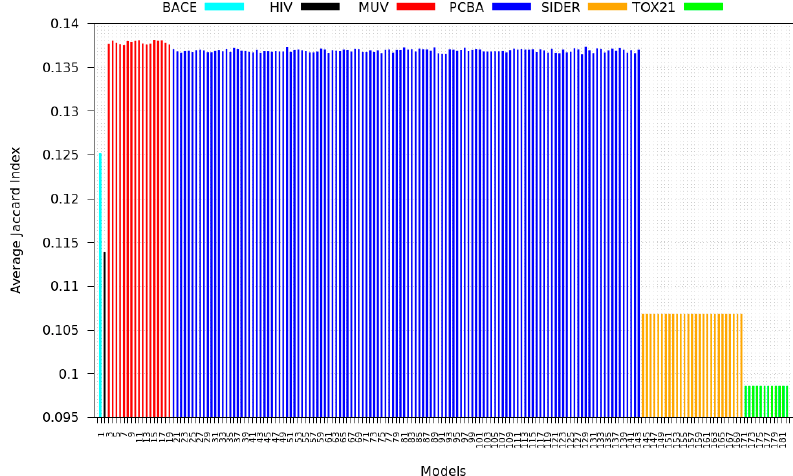
Figure A3. Histograms of the ROC-AUC improvements for each source model after fine-tuning on the target dataset.